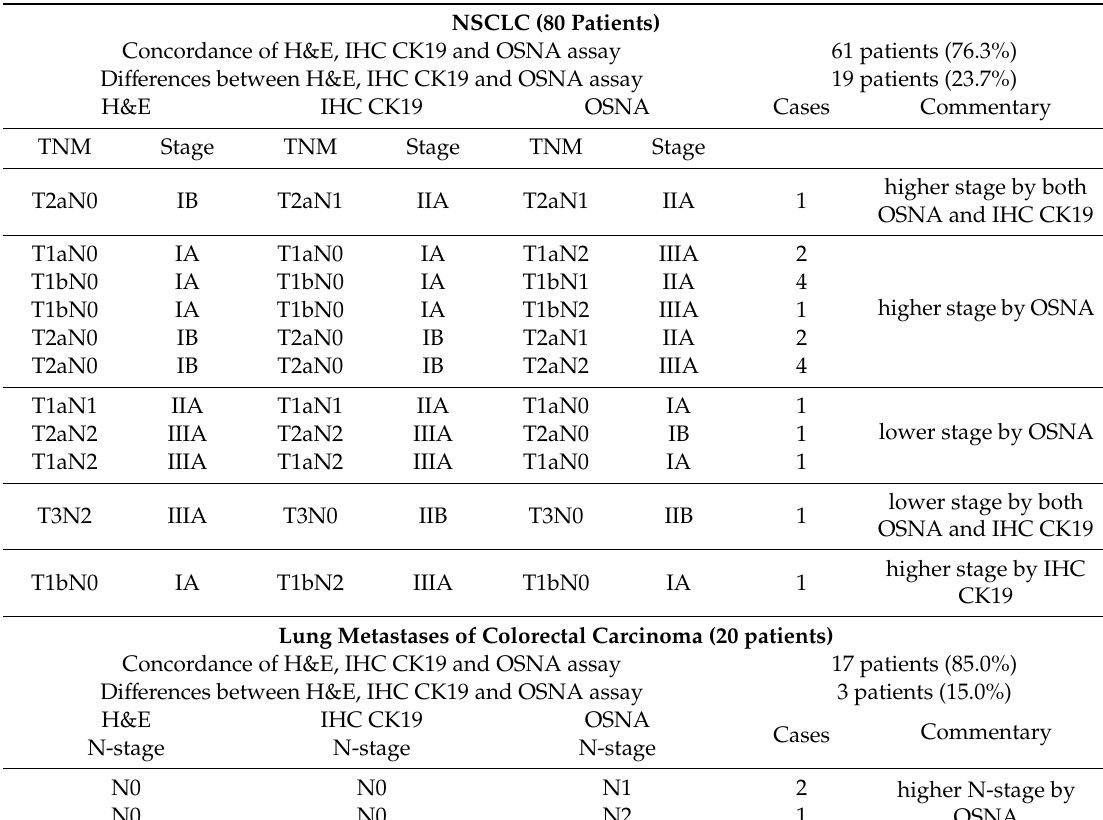
Table 3. Changes in the pTNM staging depending on H&E, IHC CK19 and OSNA